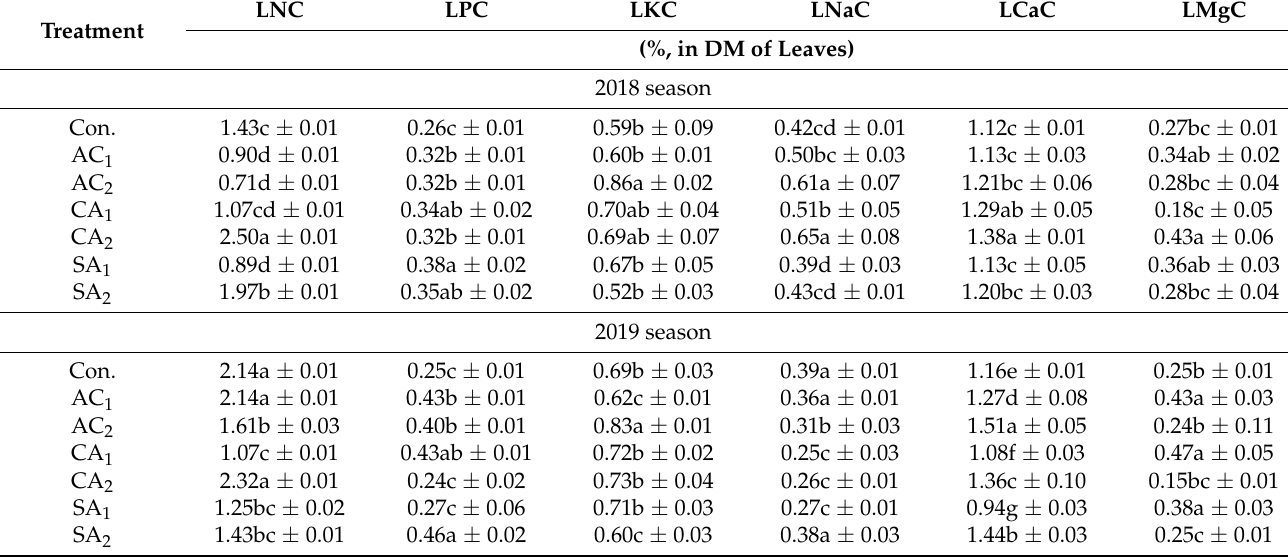
Table 4. Effect of acidifying agents as a soil application on the leaf macronutrient content of olive trees (Picual cv.) grown in a sandy loam clay soil under multi-abiotic stresses (pH = 7.78 vs. 7.89; CaCO 3 = 8.8 vs. 9.2%; and ECe = 6.4 vs. 7.2 dS m − 1